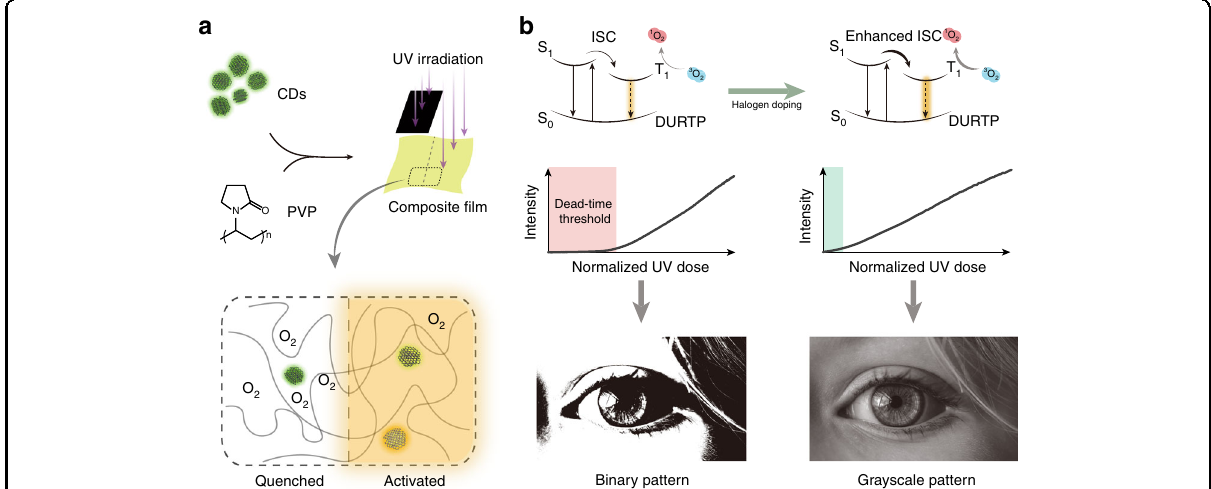
Fig. 1 Schematic illustration of the design of halogen-doped CDs composite showing DURTP with grayscale. a The photoactivation of DURTP by oxygen regulation within the composite fi lm. b Reducing the activation threshold via halogen doping to enable grayscale